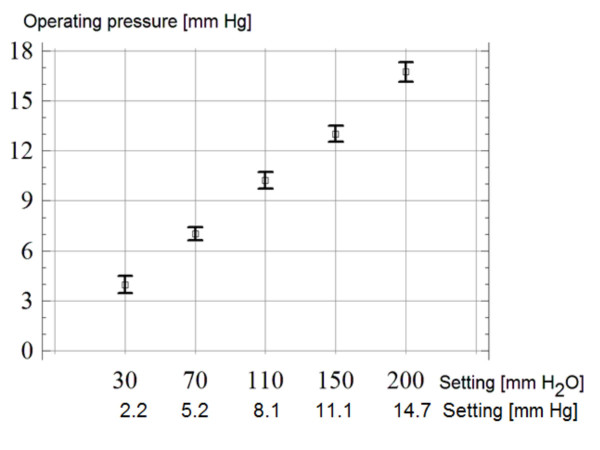
Mean values and 95% confidence limits for the valve's closing pressure at different performance levels. The test was repeated 10 times in 3 valves.